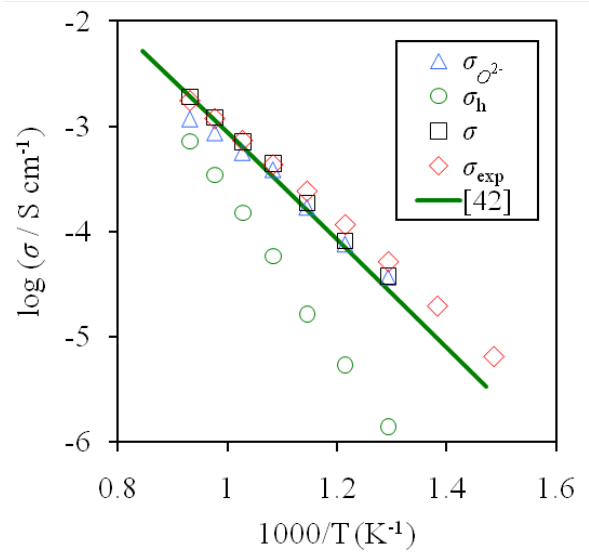
Figure 8. The calculated total, oxygen–ion and hole conductivities and the measured total conductivity of the bulk SZY sample in humid air ( p H 2 O = 3365 Pa) as functions of inverse temperature. The solid line presents the total conductivity of SrZr 0.9 Y 0.1 O 3−δ reported in [42]. The calculated and experimentally obtained values of the total, oxygen – ion and hole conductivity of the bulk SZY sample in humid air ( p H 2 O = 3365 Pa) at 550 °C and the corresponding activation energies are given in Table 1. Table 1. The calculated values of the total, oxygen – ion and hole conductivity and the measured total conductivity of bulk SZY at 550 °C in humid air ( p H 2 O = 3365 Pa) and the corresponding activation energies.